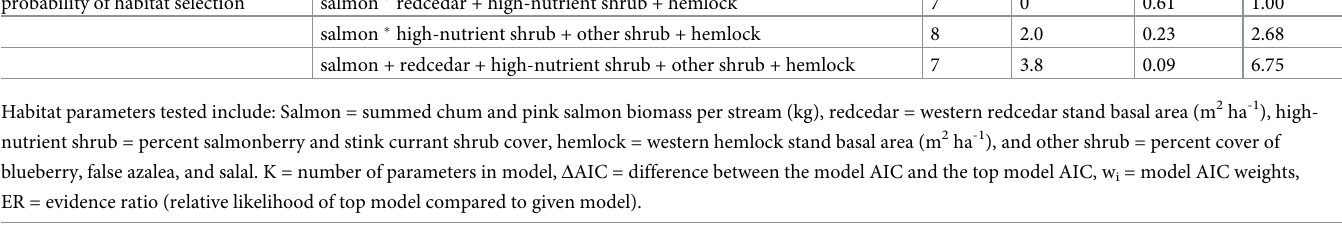
Table 2. AIC model selection from the logistic regression models for probability of habitat selection by territorial male wrens (models presented: Δ AIC < 5). Year (fixed effect) and stream (random effect) were included as variables in all models but are excluded from the table for clarity. The full candidate model set is described in S1 Table. response probability of habitat